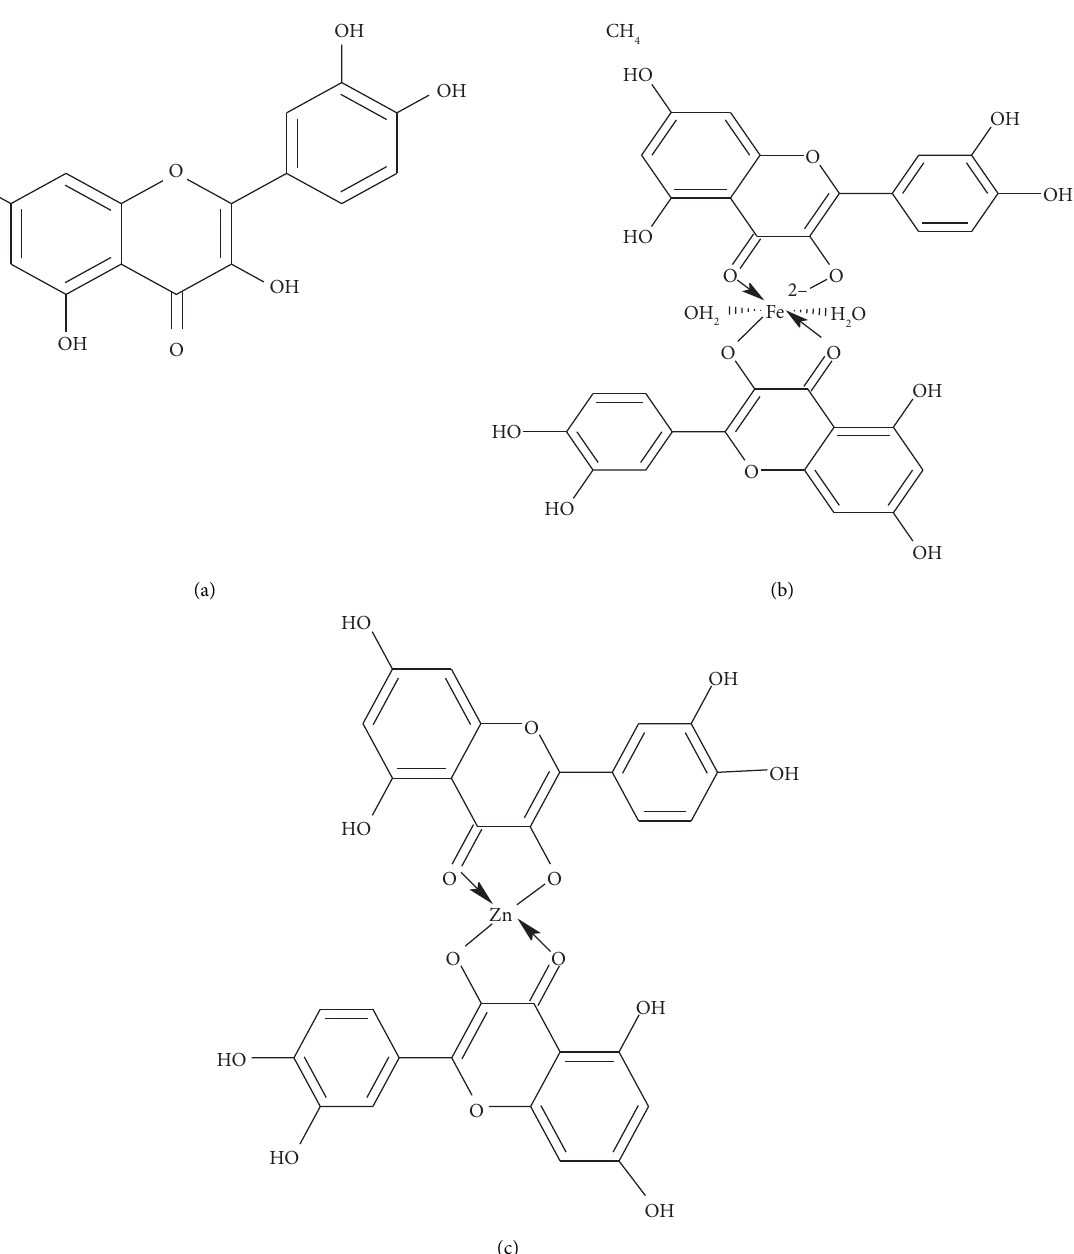
Figure 1: (a) Te structure of quercetin; (b) quercetin-zinc (Qu-Zn) metal ion complex; and (c) quercetin-iron (Qu-Fe) metal ion